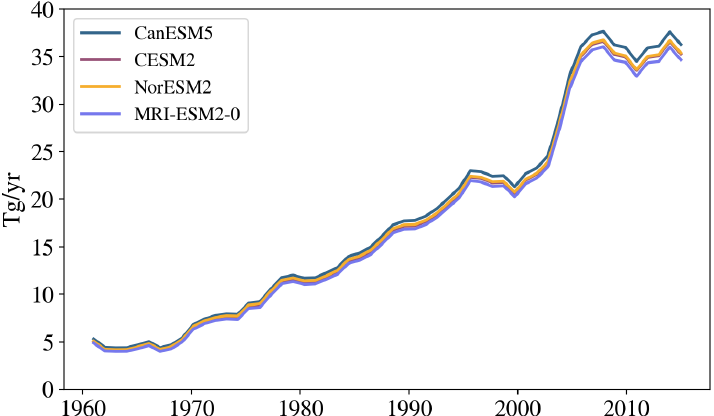
Figure A2. Emission of SO 2 in China, diagnosed by four of the models in this study. China is defined here as the area within latitudes [20–45 ◦ N] and longitudes [95–125 ◦